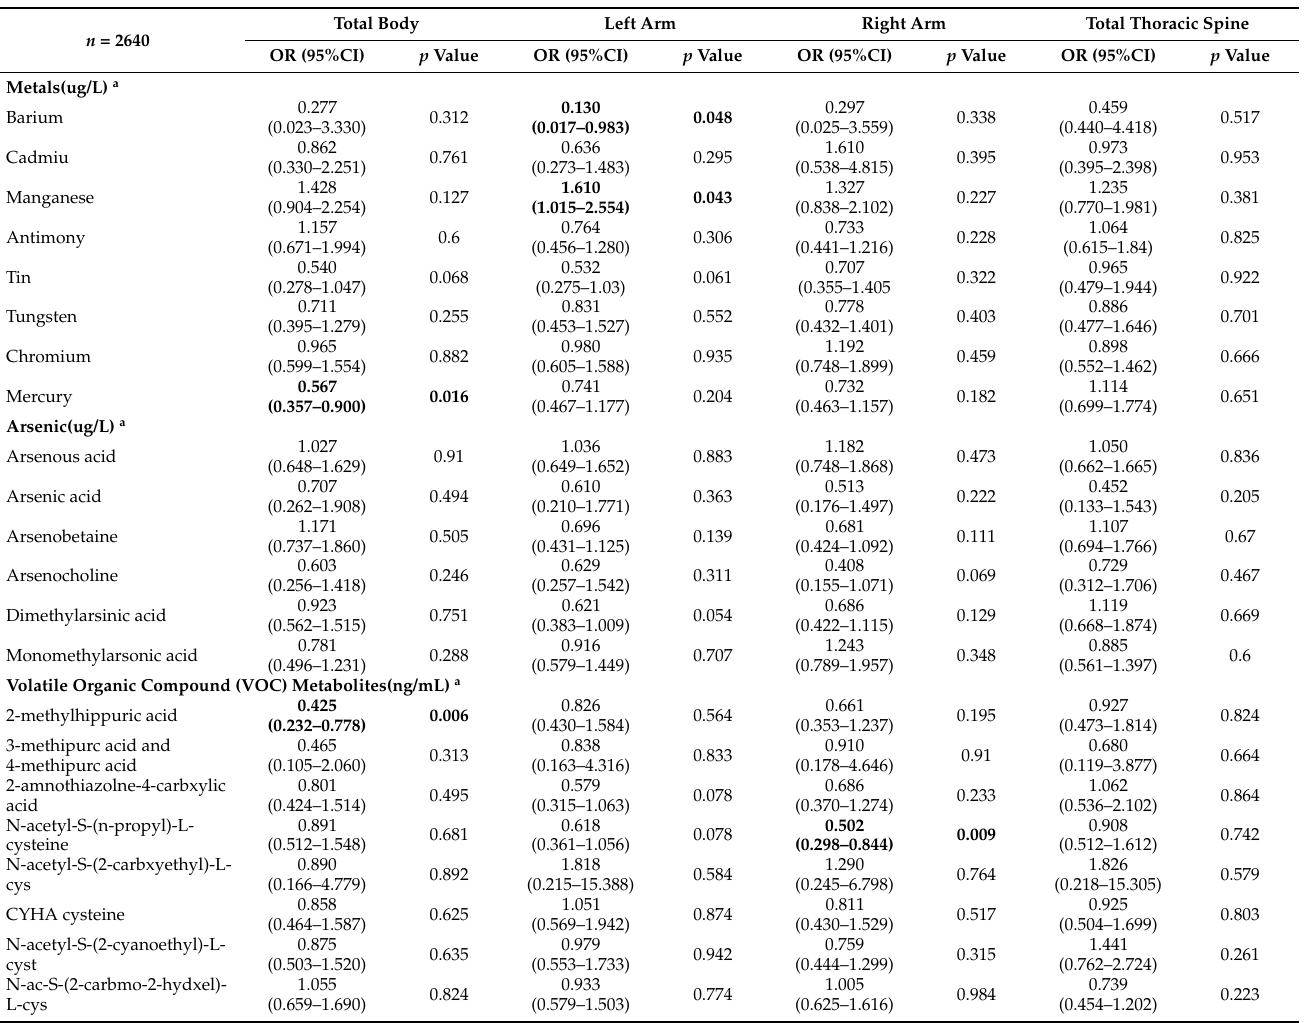
Table 3. Associations with multiple environmental chemical factors and osteopenia in